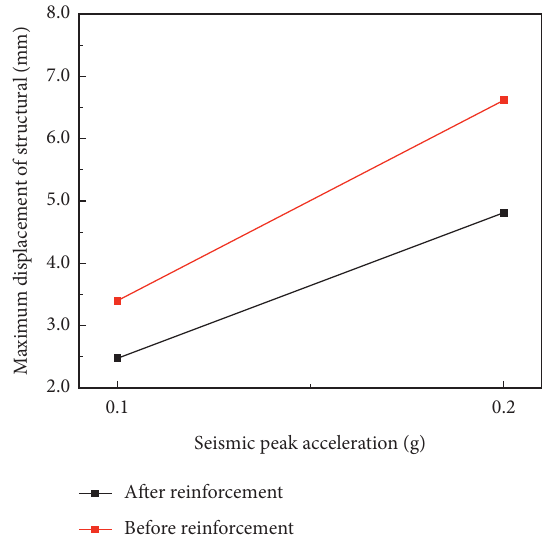
Figure 17: Comparison of the maximum displacement of the structure under Taft